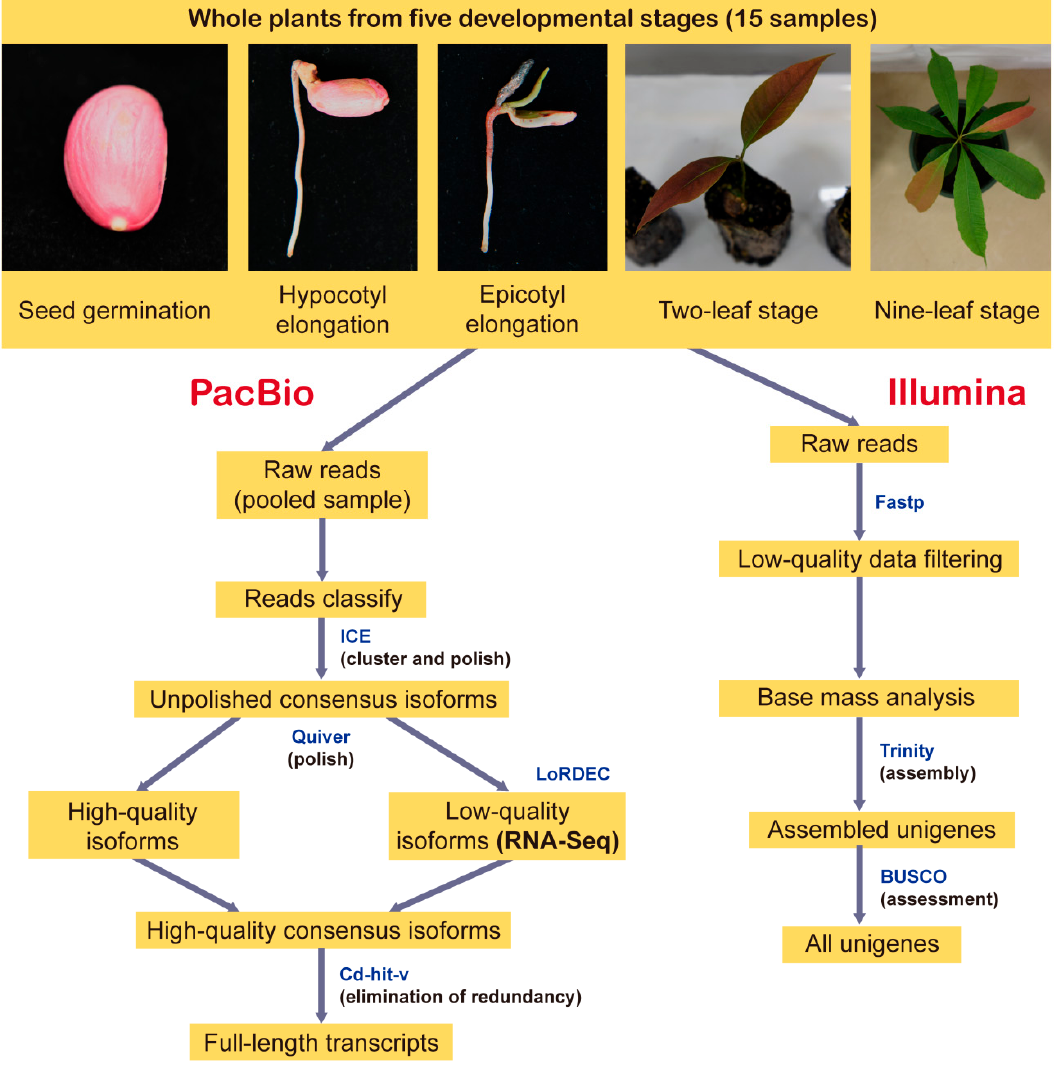
Figure 1. Images of Madhuca pasquieri (Dubard) Lam., which was used for sequencing, and the workflows used in this study.